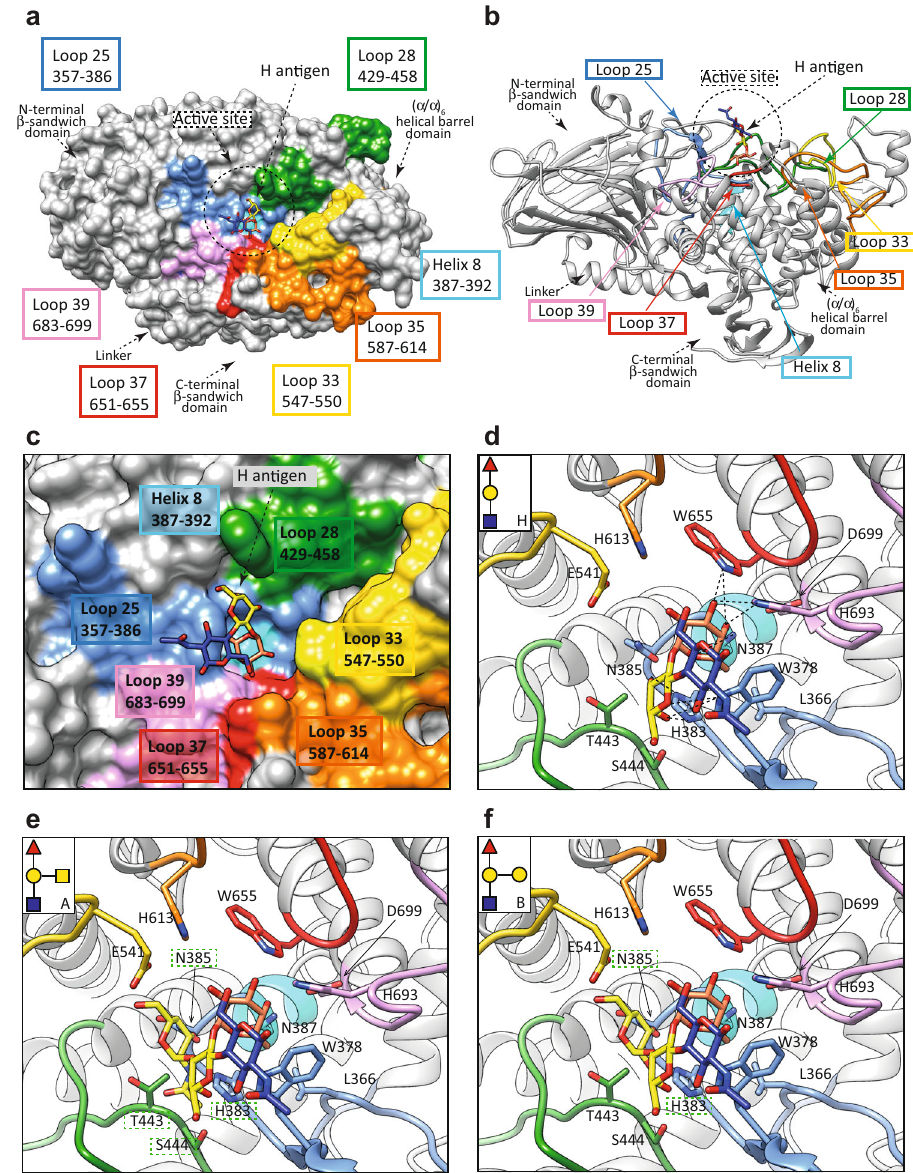
Fig.4|StructuralbasisofFucOBspeci fi cityforH-typebloodantigen.a Surface representationoftheFucOBstructure,withannotateddomainsandloops,showing the location of the Type II H antigen substrate. b Cartoon representation of the FucOBstructure,showing the locationoftheTypeIIH antigensubstrate. c Surface